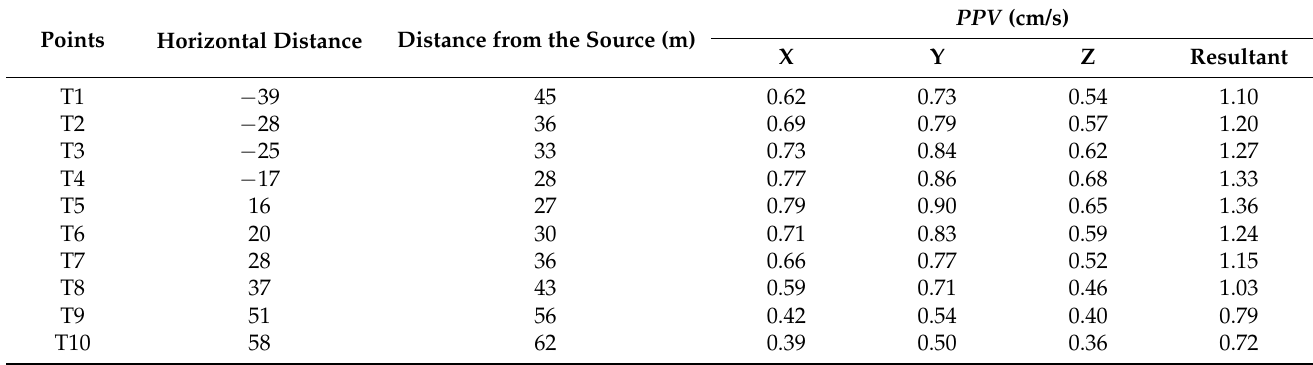
Table 2. Data monitored from the pipeline vibration levels survey.